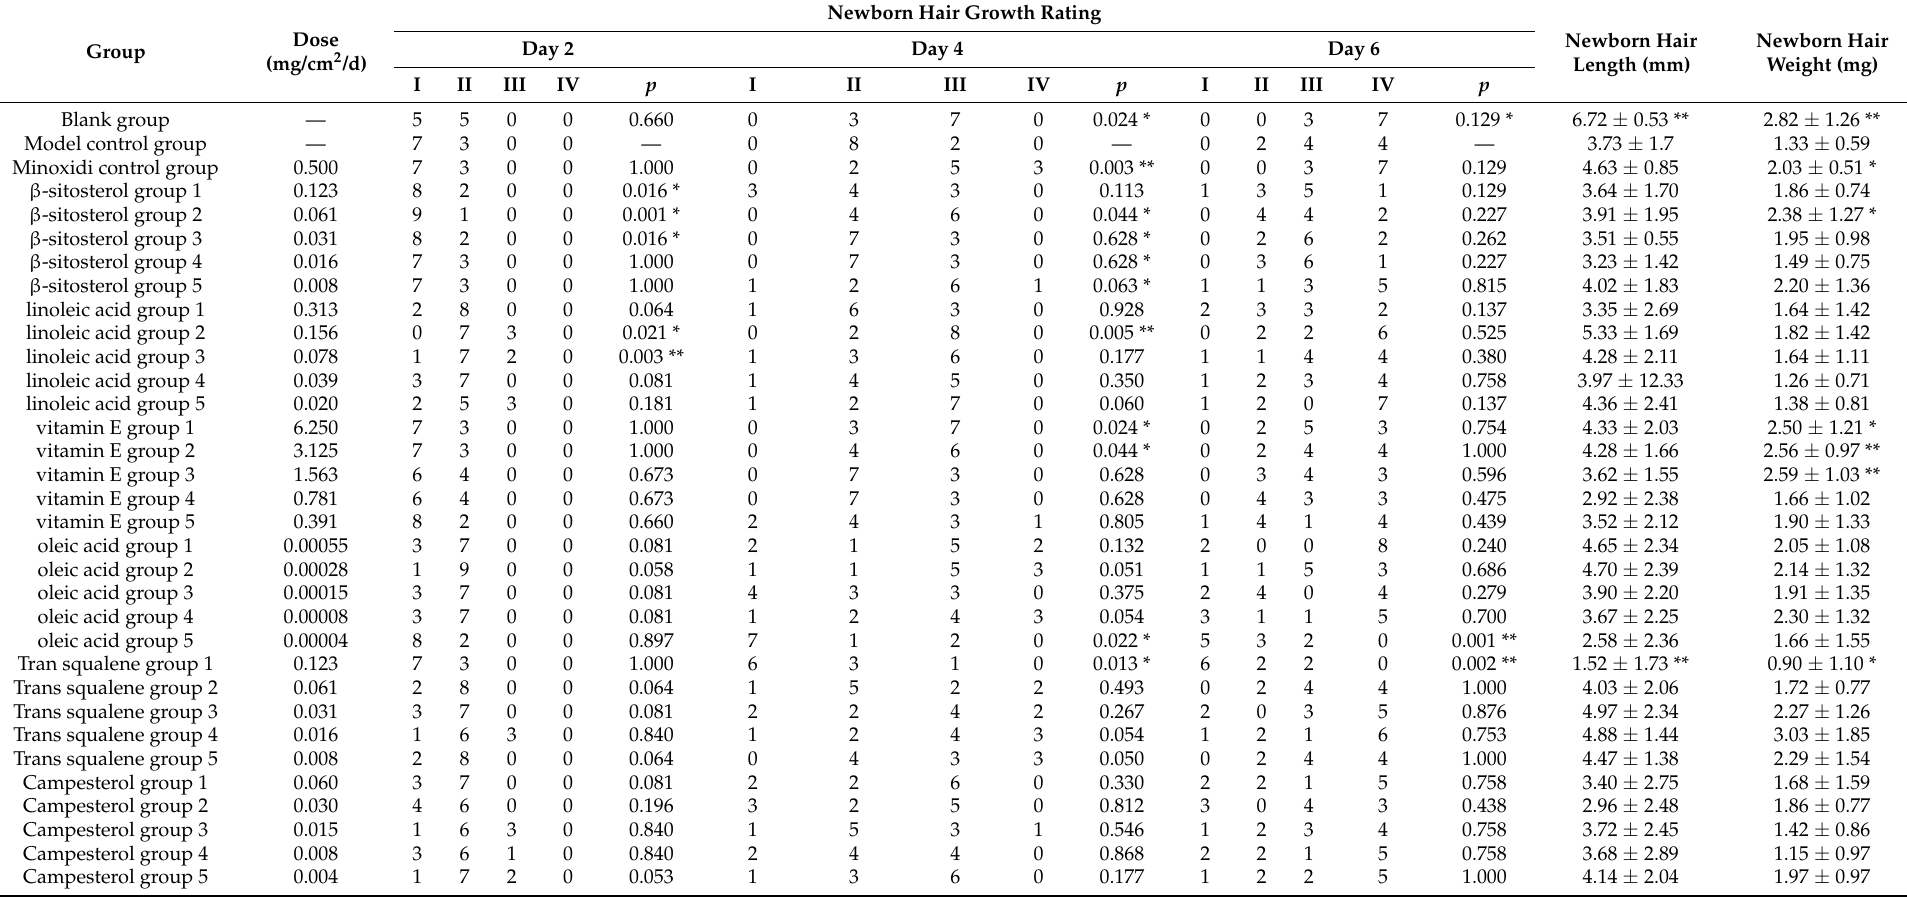
Table 13. Newborn hair growth rating, the newborn hair length and hair weight in KM mice ( n =